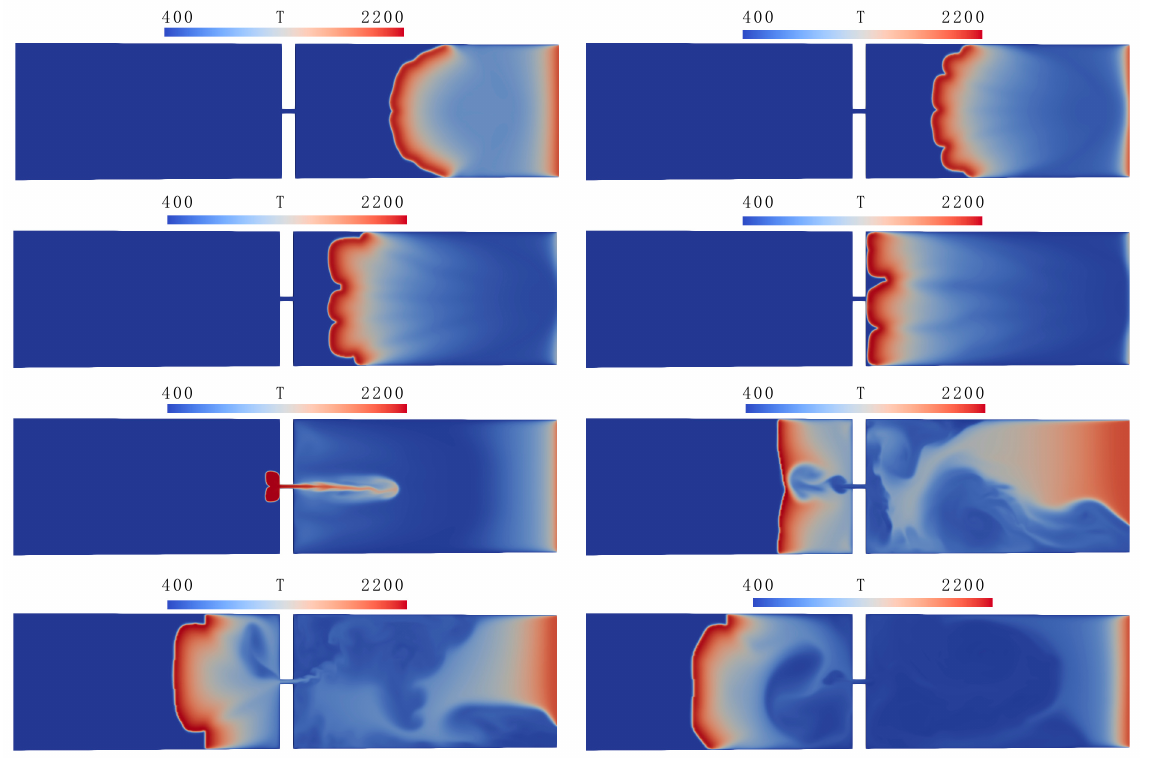
Figure 9. Flame penetration through a hole from open to closed channel part, temperature distributions in the symmetry plane z = 0 at times 100, 300, 500, 700, 900, 1100, 1200, and 1560 ms ( top to bottom , left to right ).